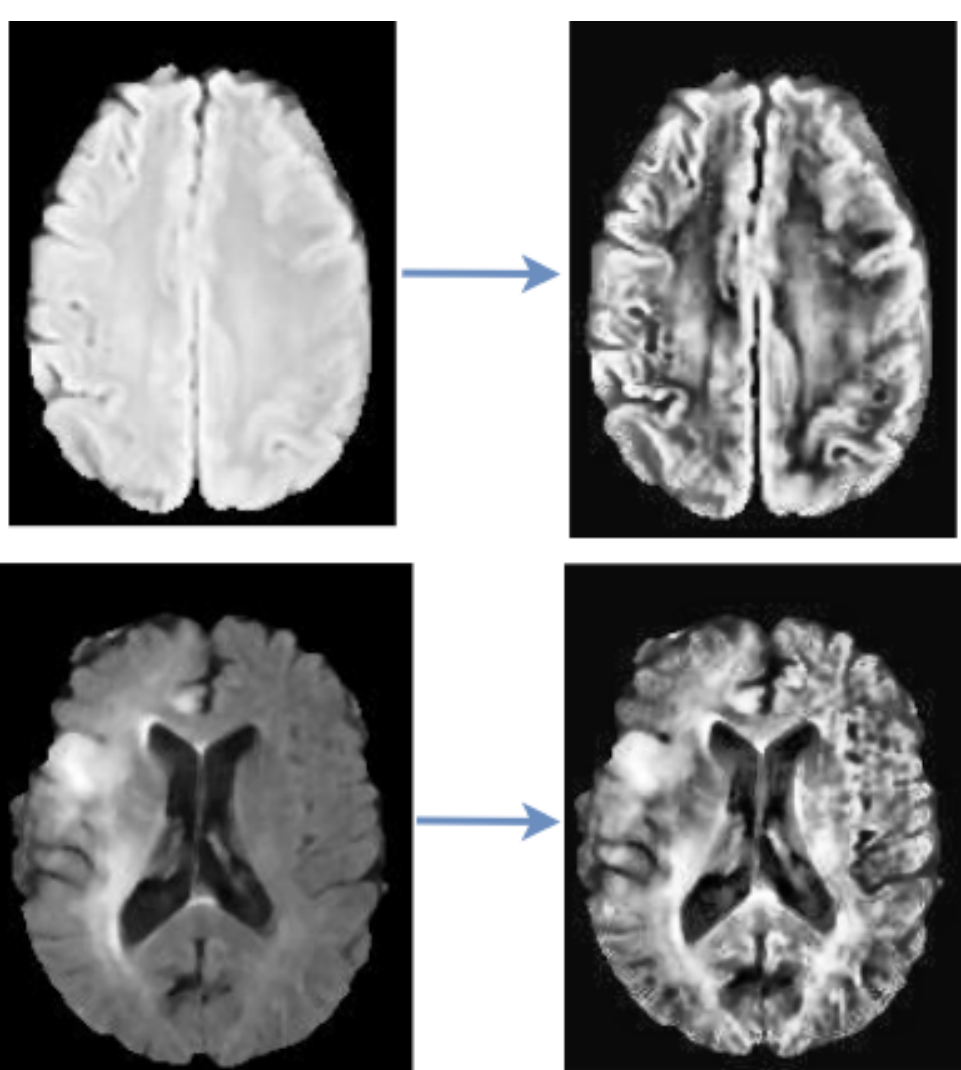
Figure 2. CLAHE Pre-processing. The images on the left are the raw images while the images on the right are the processed